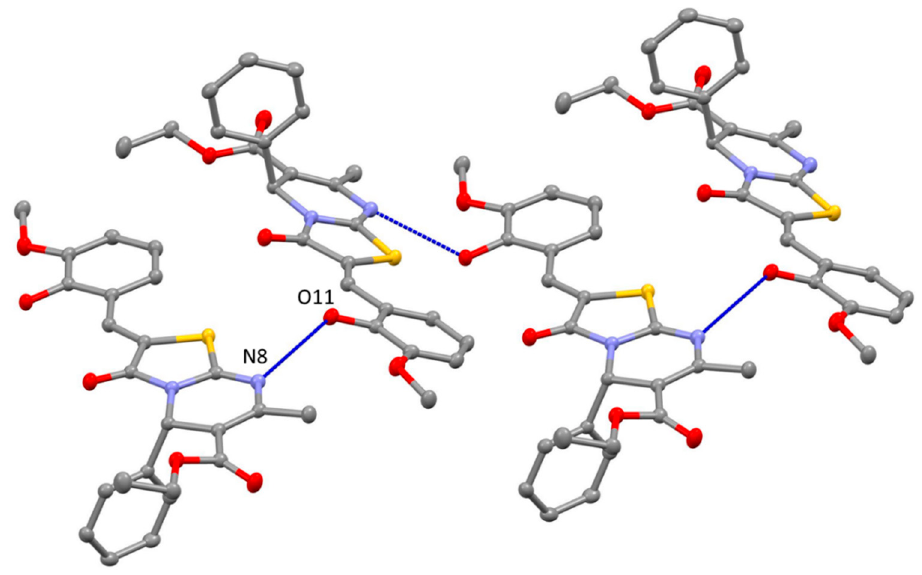
Figure 5. A portion of the homochiral crystal structure of 4, showing formation of the 1D H-bonded zigzag chain composed of only the S-isomer molecule. Hydrogen bonds are shown in light blue dotted lines.